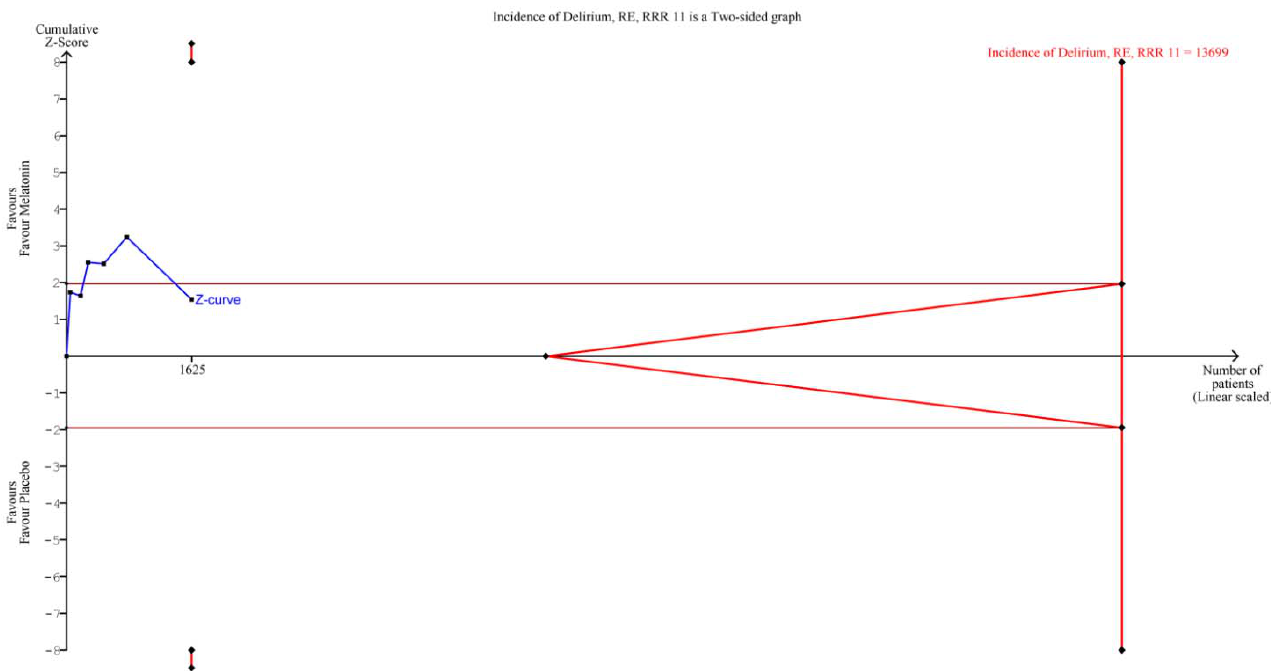
Figure 2. Trial sequential analysis on delirium incidence. Abbreviations: RE, random effect; RRR, relative risk reduction.